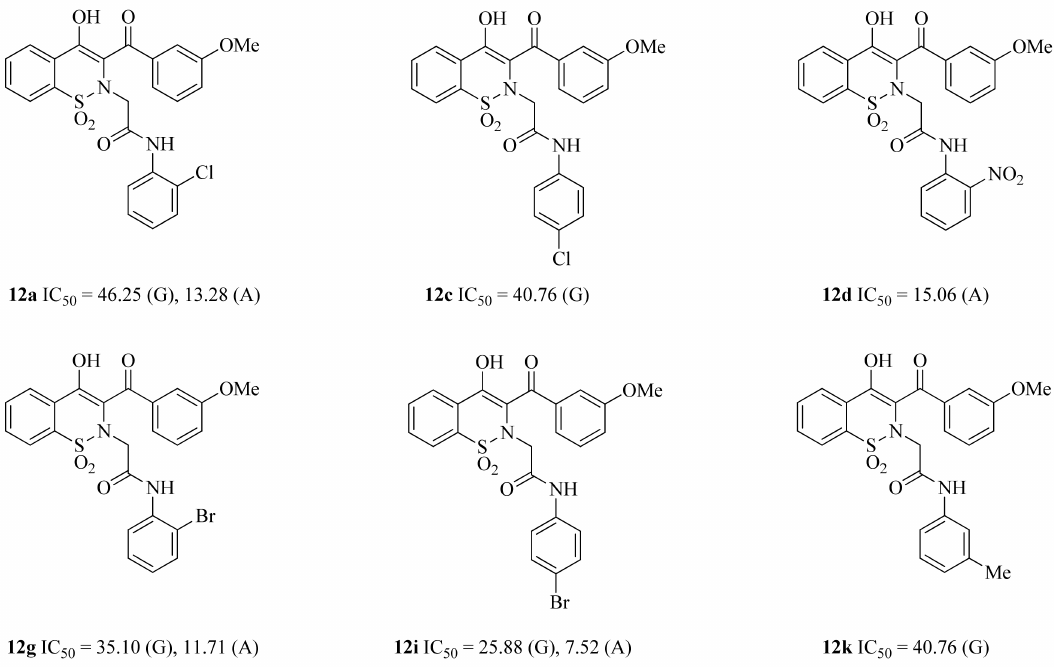
Figure 5. Structures of most potent compounds. IC 50 values are in µ M. (G) and (A) stands for α -Glucosidase and α -Amylase enzymes, respectively. Acarbose IC